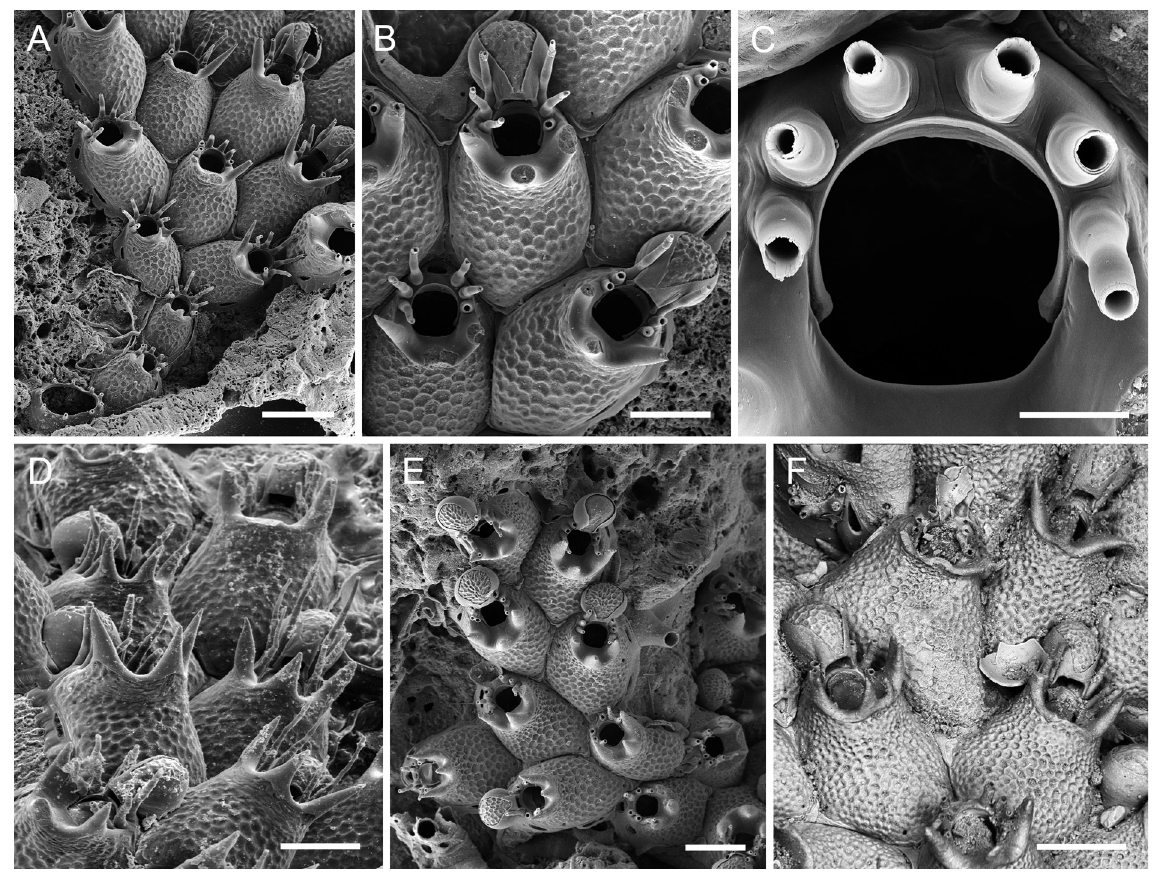
Fig. 6. Atlantisina tricornis gen. et sp. nov. A . Early colony development; note the presence of the maternal 5th-generation autozooid at centre right (paratype MNHN-IB-2014-64, N Iberian slope). B . Ovicellate zooids (paratype MNHN-IB-2014-65, N Iberian slope). C . Close-up of orifice (paratype MNHN-IB-2014-65, N Iberian slope). D . Lateral view of suboral crests (holotype MNHN-IB-2014-60, N Iberian slope). E . Colony from Galicia Bank forming biserial ribbons; note the relatively broad ooecia (MNHN-IB-2014-279). F . Colony from the W Iberian slope (photo taken by J. Souto); note the bifid tips in some of the mucrones (zooid at lower left) while other suboral crests (zooid at top right) have a simple trident (MNHN-IB-2008-7194). Scale bars: A, E–F = 300 µm; B, D = 200 µm; C =